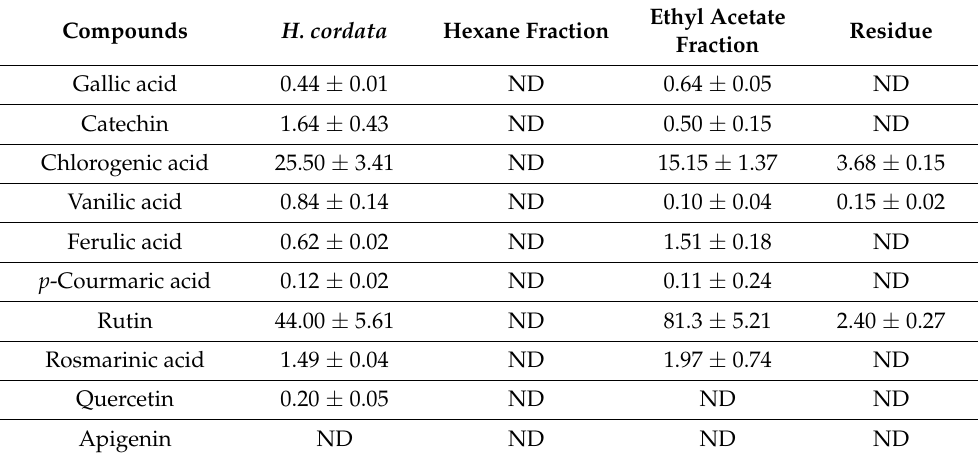
Table 1. Chemical components of HCT ( Houttuynia cordata Thunb.) and its fractions.